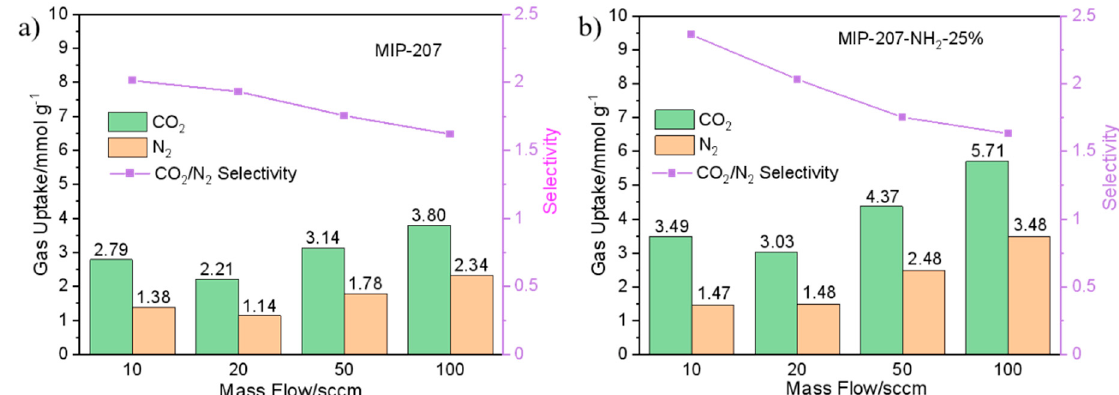
Figure 8. Dynamic CO 2 and N 2 adsorption and separation performance of ( a ) MIP-207 and ( b ) MIP-207-NH 2 -25%.